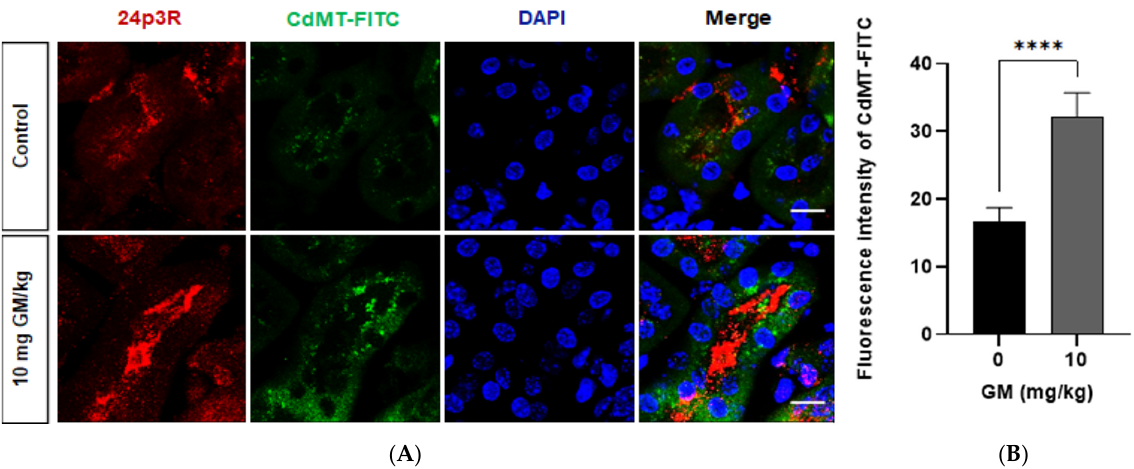
Figure 11. Internalization of the CdMT-FITC complex increases in renal cortex cells expressing 24p3R (DT and possibly CD) after GM exposure. ( A ) Representative micrographs of cells expressing 24p3R from untreated and GM-exposed mice. Nuclei are stained with DAPI (blue). Scale Bar = 50 µm; ( B ) Bar chart displaying means ± SD of five randomized photographs per animal (three animals per group). Quantification of CdMT complex immunofluorescence intensity (green) was performed on kidney sections stained for 24p3R (red). Student’s t -test was performed, **** p < 0.0001.